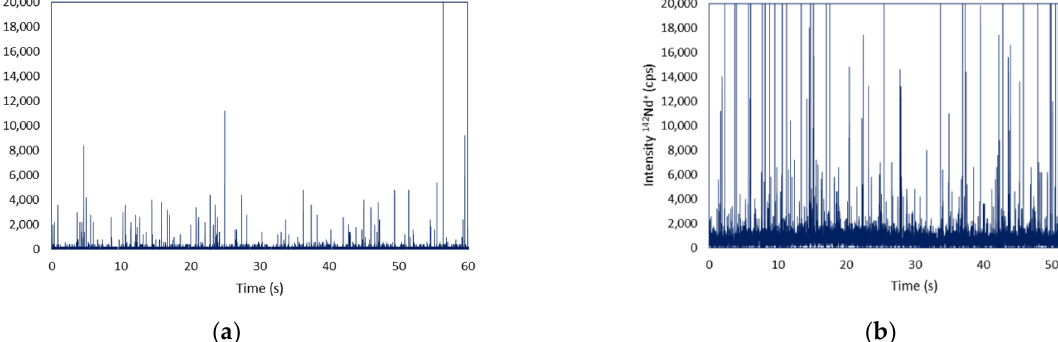
Figure 5. Time-resolved single cell ICP-MS analysis monitoring 142 Nd + in the ( a ) liver and ( b ) HepG2 cells after cell tagging with the Nd-conjugated antibody.